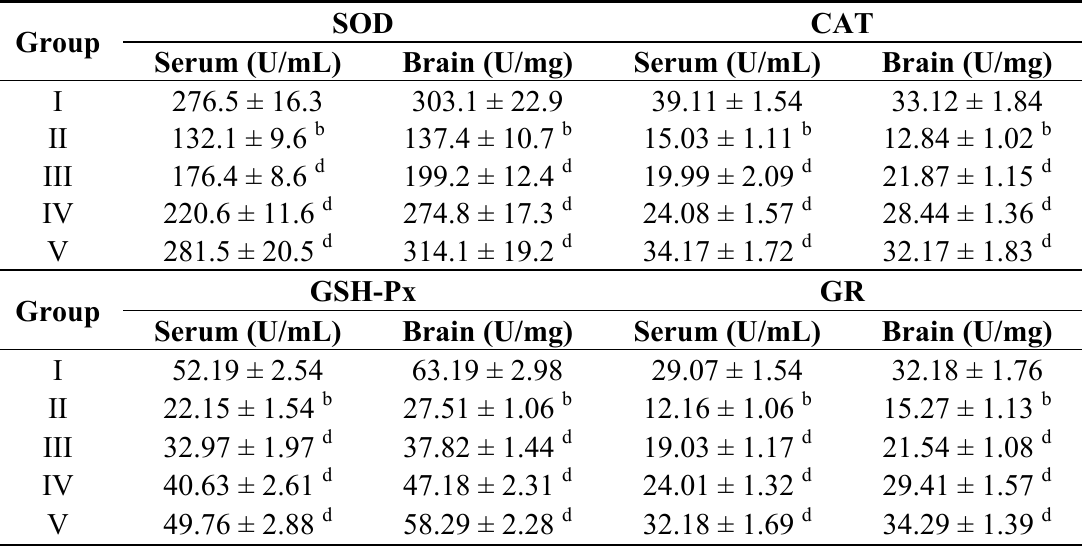
Table 5. Effects of sevoflurane postconditioning on serum and brain SOD, CAT, GSH-Px and GR